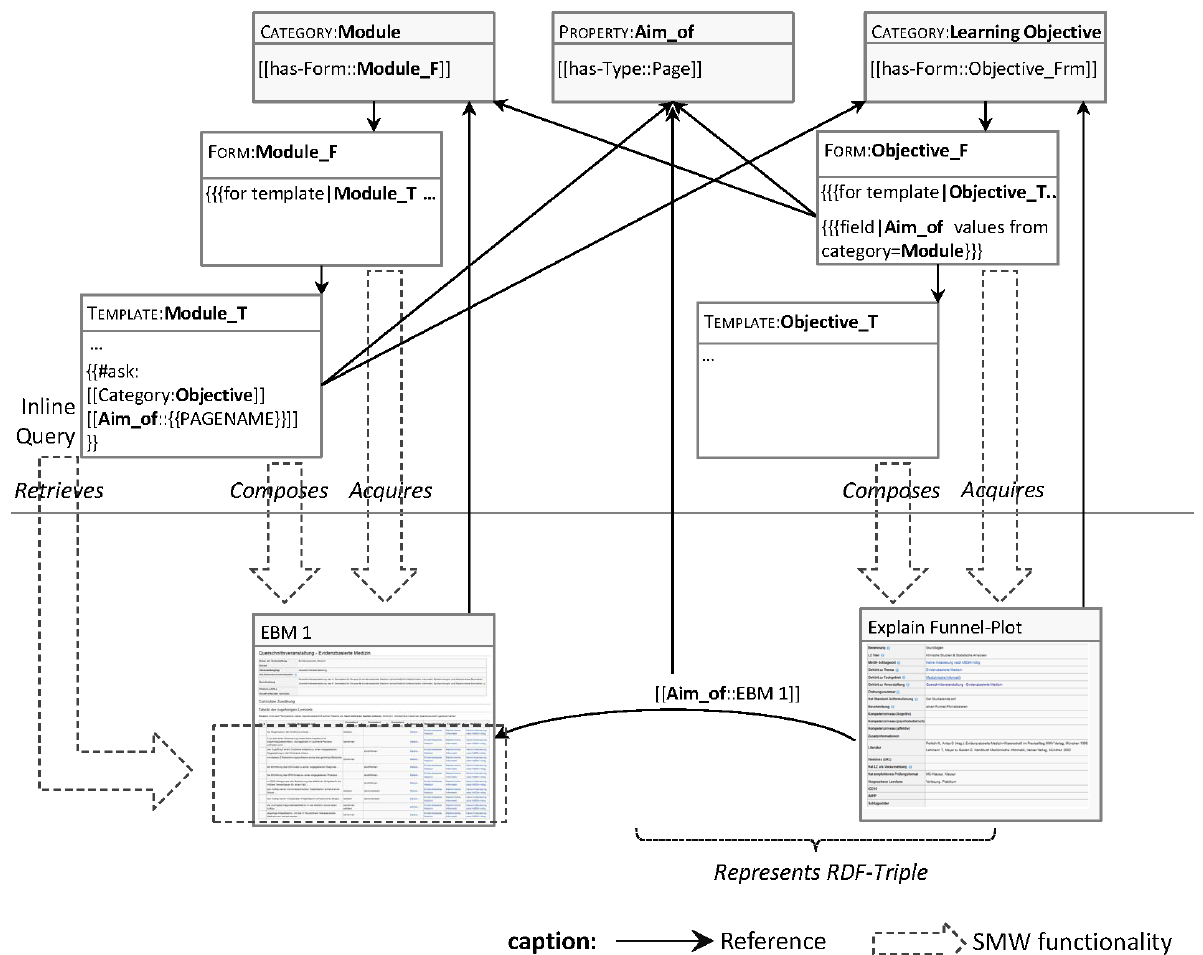
Figure 1. The SMW-based approach to the representation and acquisition of curricular information, illustrated by an example taken from ACLO-Web; the diagram includes abbreviated SMW syntax in order to illustrate why the references between the different building blocks are